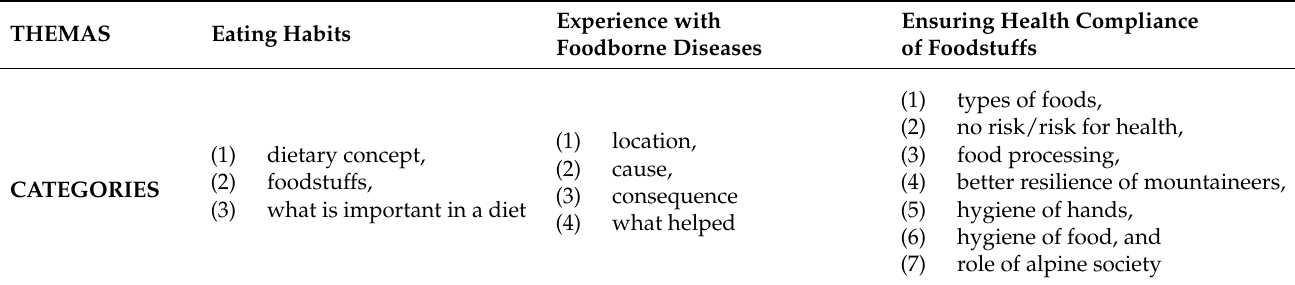
Table 2. Theme and categories of qualitative